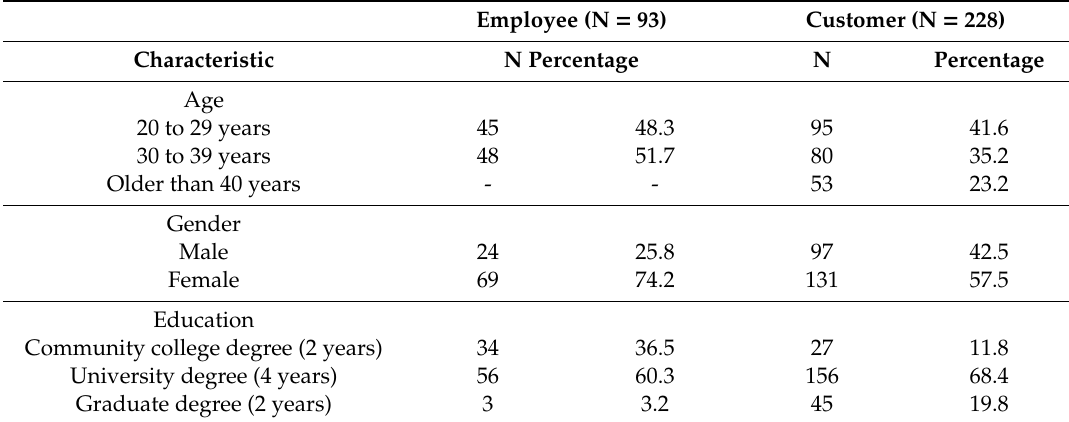
Table 1. Profile of the sample.